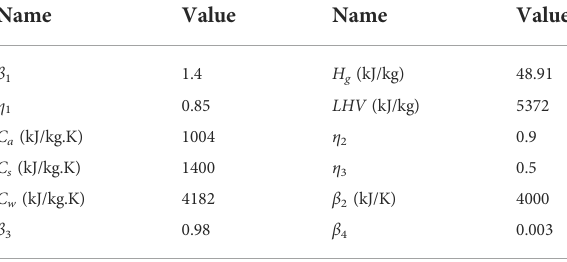
TABLE 1 Parameters of CHP unit in Case